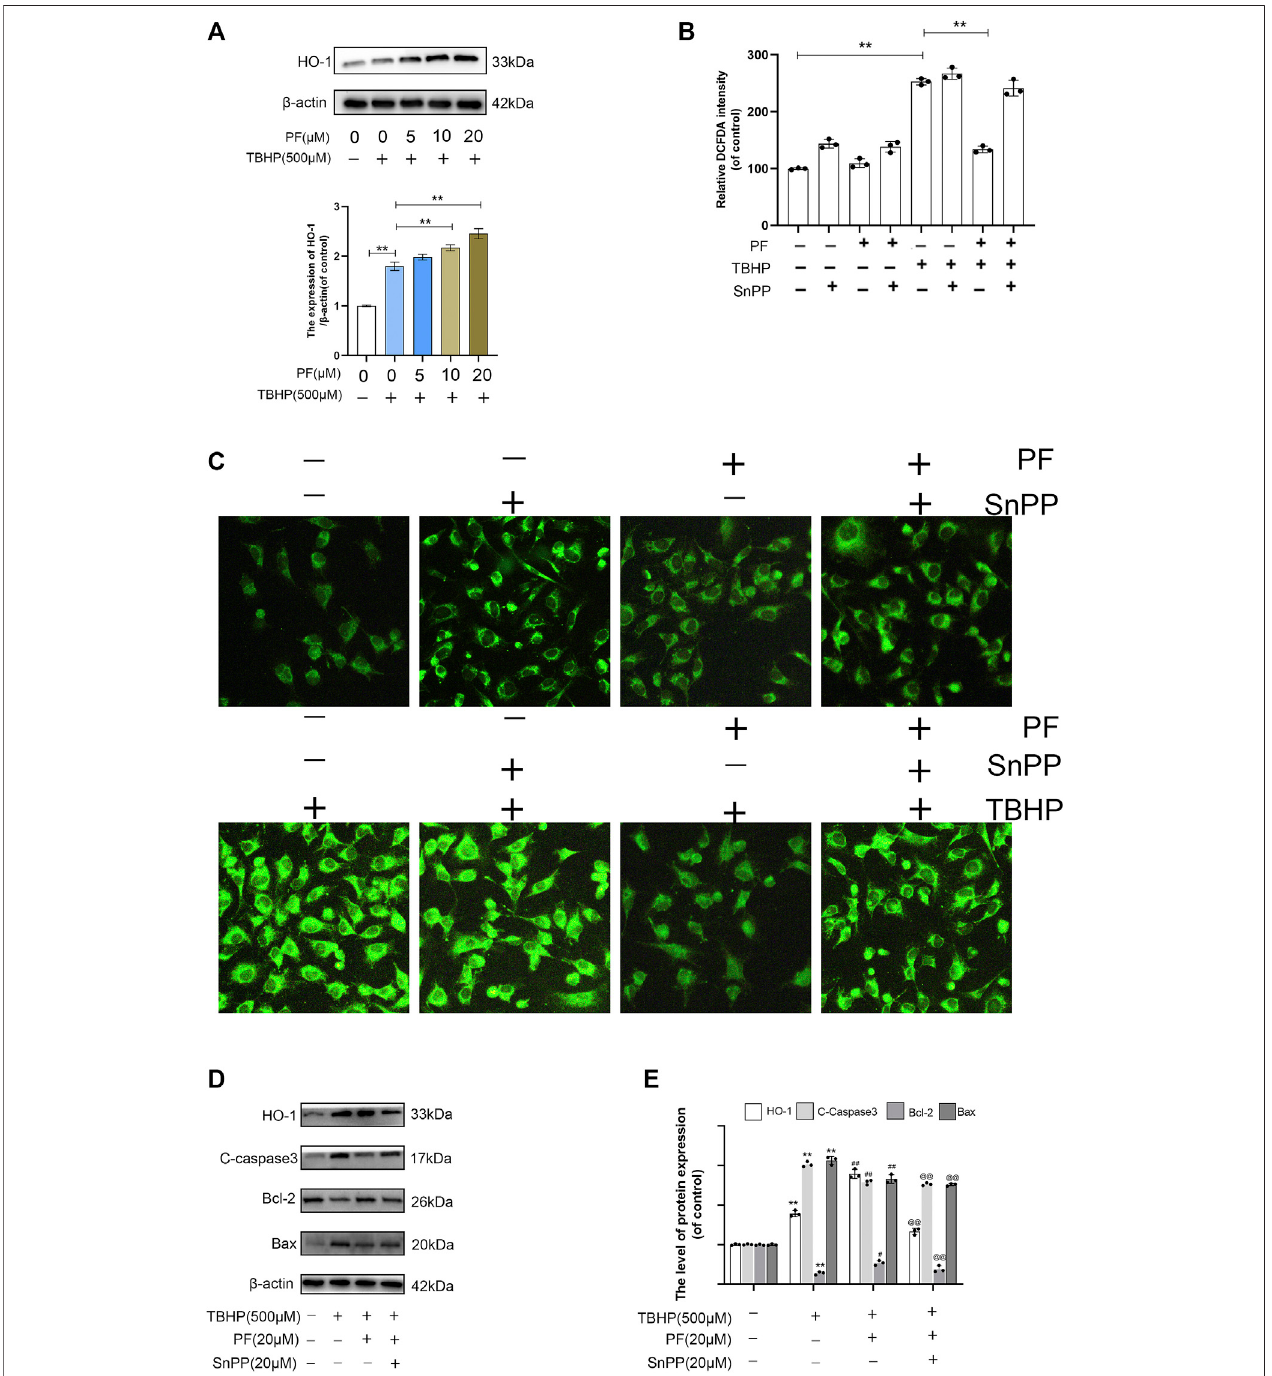
FIGURE5| Paeoni fl orin (PF) protected HUVECs from TBHP-induced oxidative stress via HO-1activation. (A) Evaluation oftotal HO-1 protein byWesternblotting. (B) PercentageofDCFDAstainingintensityunderdifferenttreatedgroupsanddetectedby fl uorescencemicroscope. (C) RepresentativeimagesofDCFDA fl uorescence performed to exhibit the intracellular ROS level under different conditions. (D,E) Evaluation of HO-1, cleaved caspase-3, Bcl-2, and Bax proteins using Western blotting for each grouptreatedwith/without TBHP,PF, and protoporphyrinIX(SnPP).Data:mean ± SD,** p < 0.01vs controls.# p < 0.05,## p < 0.01 vs.TBHP-stimulated HUVECs. @ p < 0.05, @@ p < 0.01 vs. TBHP+PF co-treated HUVECs. n (cid:2) 3.